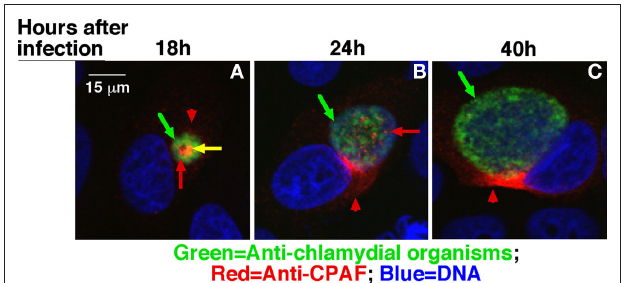
Figure 2 | Detection of CPAF in chlamydial organism-free vesicles in the lumen of chlamydial inclusions. The Chlamydia trachomatis -infected HeLa cells grown on coverslips were processed at 18 h (A) , 24 h (B) , or 40 h (C) after infection as indicated on top of the figure for an immunofluorescence assay as described in Figure 1 legend except that the monoclonal antibody 100a against CPAF was used to replace the mouse antibodies and a rabbit anti-chlamydial organism antibody was used to replace the anti-IncA antibody. The images were also acquired using an Olympus confocal microscope. Green arrows indicate chlamydial organisms. Red arrows indicate CPAF-laden granules that are free of chlamydial organisms while the yellow arrow indicates CPAF that overlaps with chlamydial organisms. Red arrowheads indicate CPAF molecules secreted into host cell cytosol. Please note that at the early time points, CPAF was detected in granules in the inclusions and many of the CPAF-positive granules were free of chlamydial organisms in the 24 h